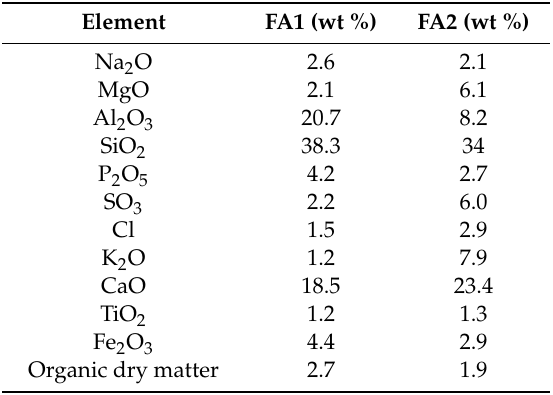
Table 3. Comparison of inorganic fraction of fly